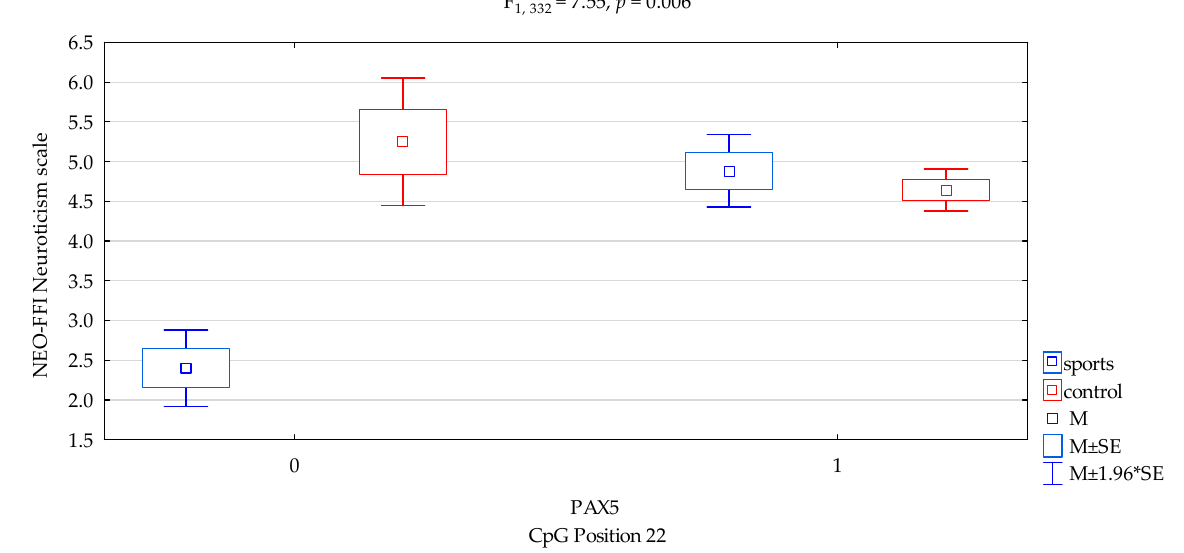
Figure 3. Interaction between sports subjects/control and DAT1 PAX5 CpG sites 22 and NEO FFI Neuroticism scale. Methylation status: yes—1, no—0. M ± SE—mean ± standard error, M ± 1.96*SE—mean ± s1.96*standard error.